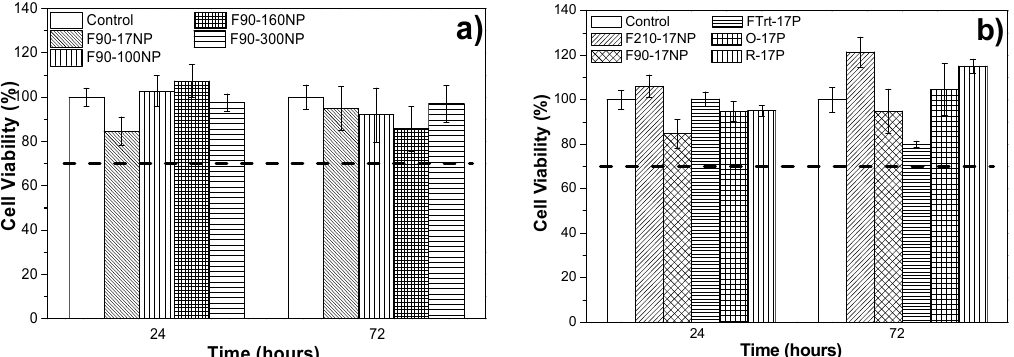
Figure 10. Cytotoxicity indirect test of ( a ) samples prepared with nanoparticles of different diameters and prepared by solvent evaporation at 90 ◦ C and ( b ) samples prepared with SiNPs of 17 nm diameter after different processing methods and therefore with different